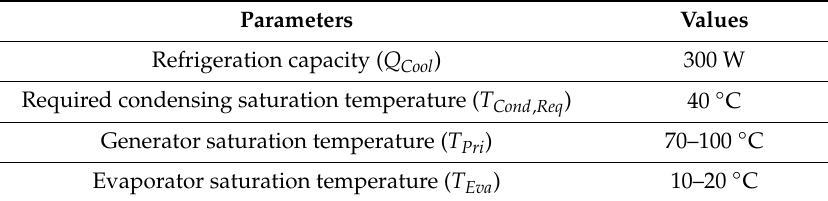
Figure 13. Schematic for simple refrigeration system. Table 4. Specifications of refrigeration system.